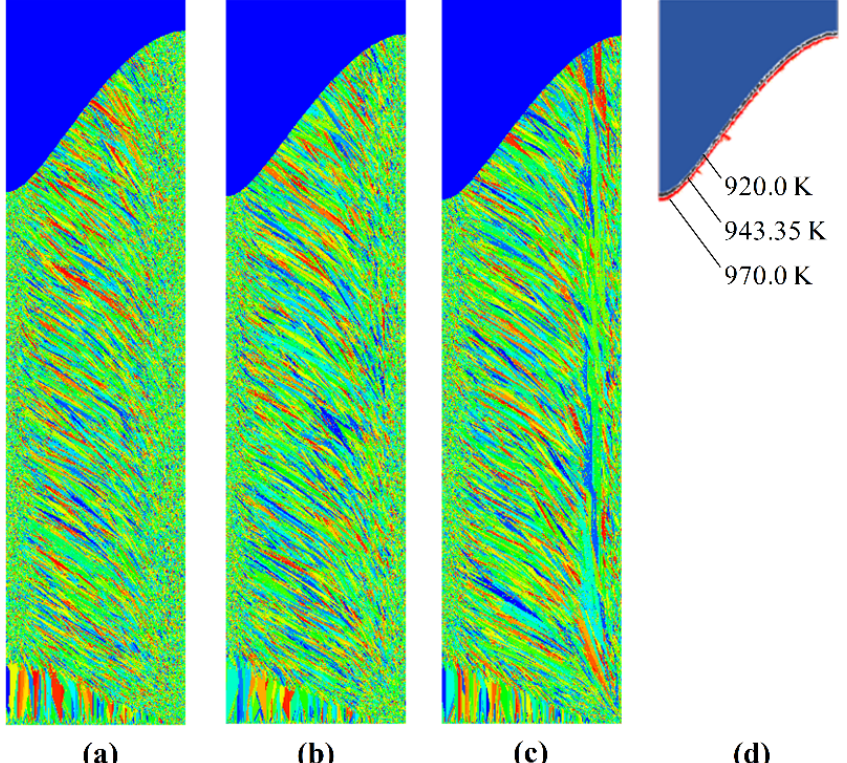
Figure 10. Grain structures predicted in the non-grain-refined billet with three different casting temperatures of ( a ) 920 K (case 5), ( b ) 943.35 K (case 2), and ( c ) 970 K (case 6), accompanied with ( d ) the growth front profiles when the maximum height is reached.